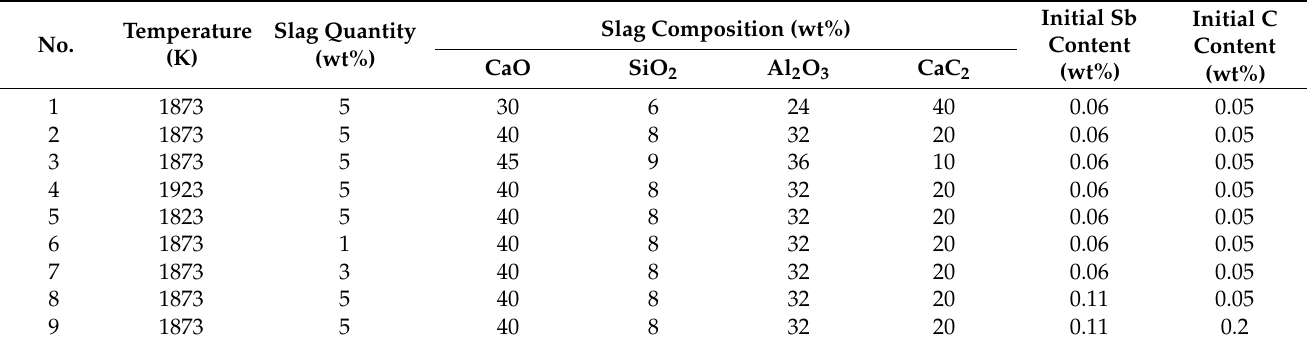
Table 3. Experimental parameters of each